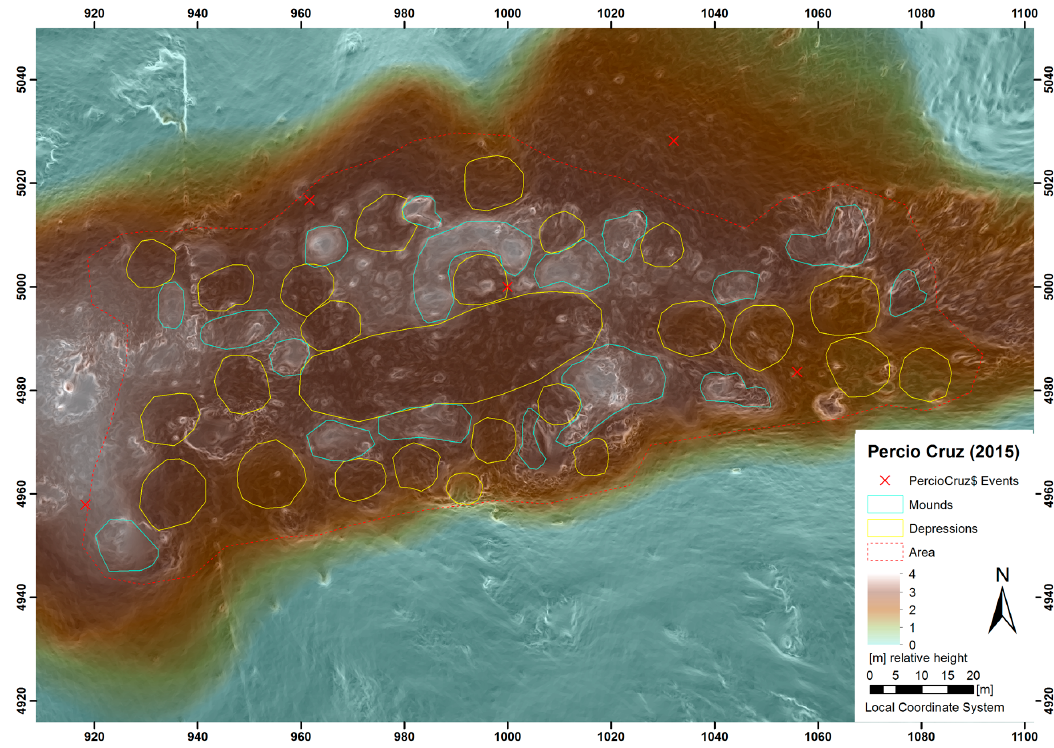
Figure 6. DEM overlaying a hill shade model, and the interpretation of mounds and flattened areas at the settlement site of Percio